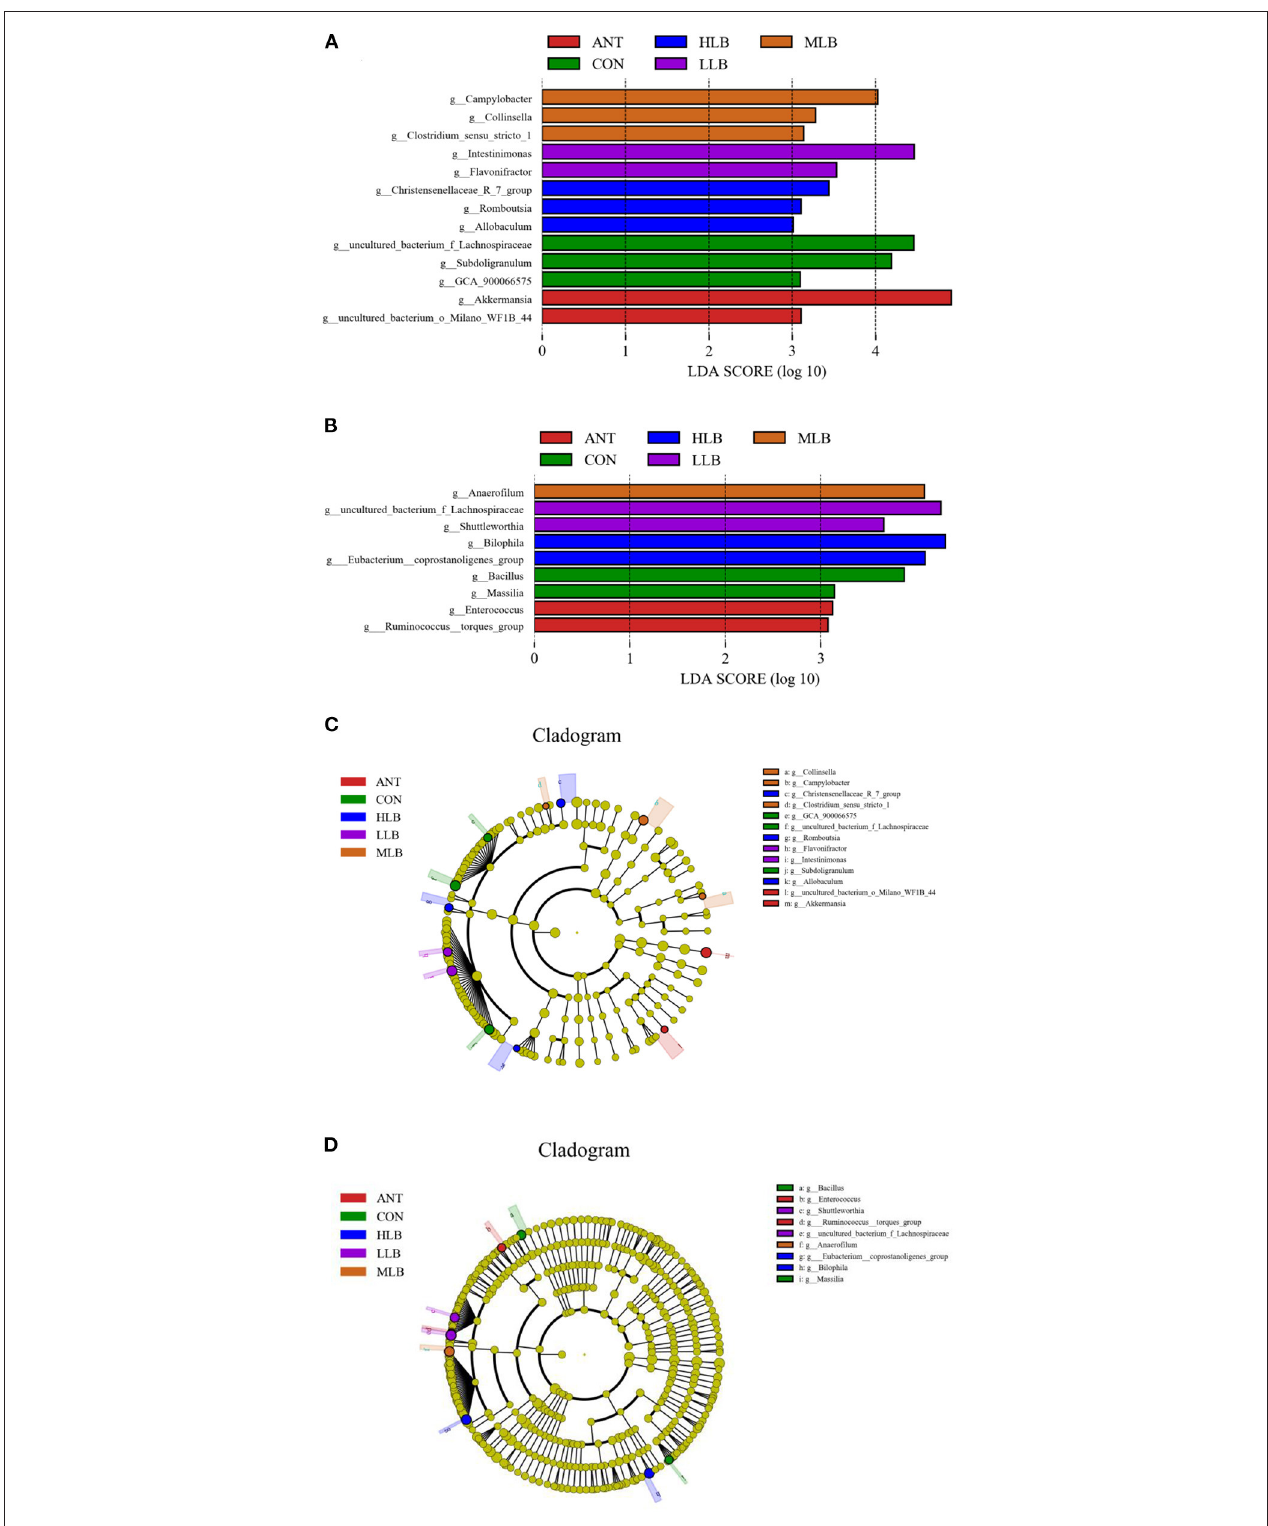
FIGURE 5 | Histogram of LDA value distribution between different groups and LEfSe analysis evolutionary branching diagram, n = 6 for each group. Histogram of LDA values of intestinal microflora of Pekin ducks at 21 days (A) and 42 days (B) in the control group (CON) and the medium dose group (MLB). LEfSe analysis of evolutionary branching of intestinal microflora of Pekin duck at 21 (C) and 42 days (D) in the control (CON) and the medium dose (MLB) groups.